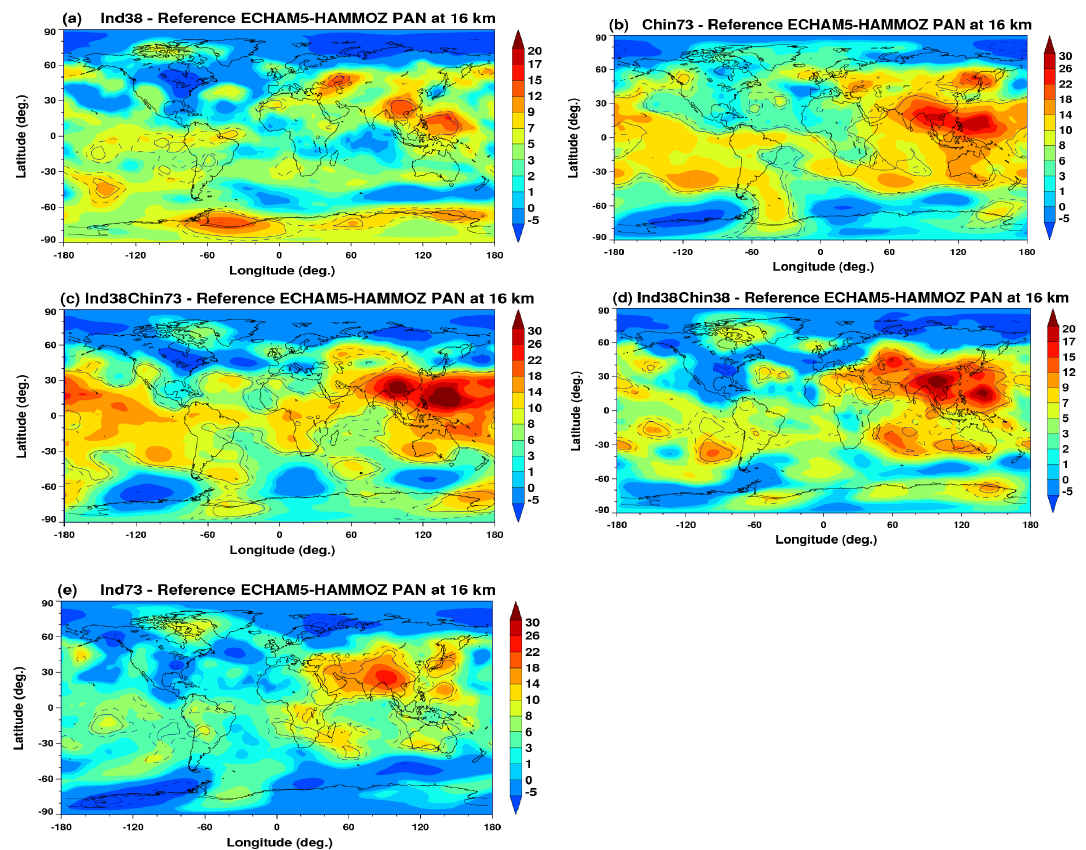
Figure 5. Percentage change in ECHAM5-HAMMOZ PAN at 16km, as obtained from (a) Ind38, (b) Chin73, (c) Ind38Chin73, (d) Ind38Chin38 and (e) Ind73 simulations. Solid black line indicates the 95% Student’s t test confidence interval while the dashed line indicates 90% confidence